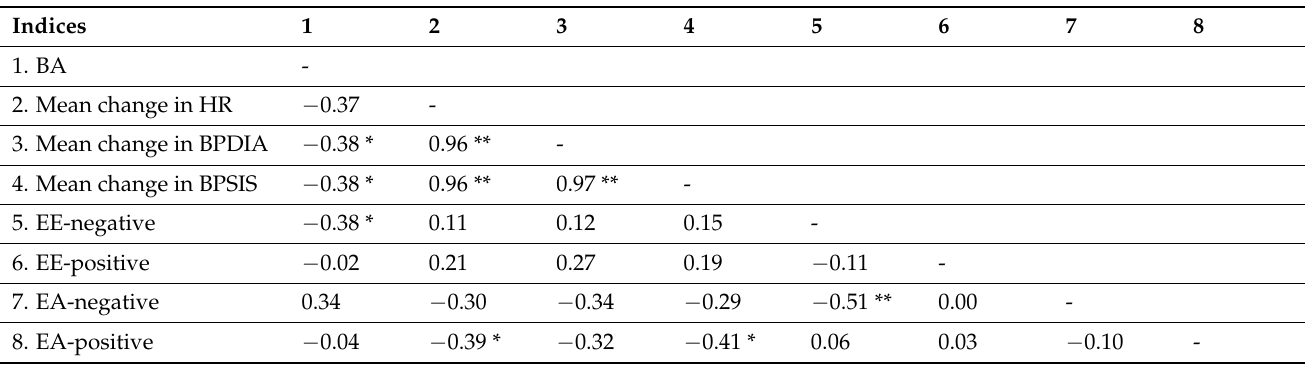
Table 9. Pearson correlations and significance of Experiment 2 variables.